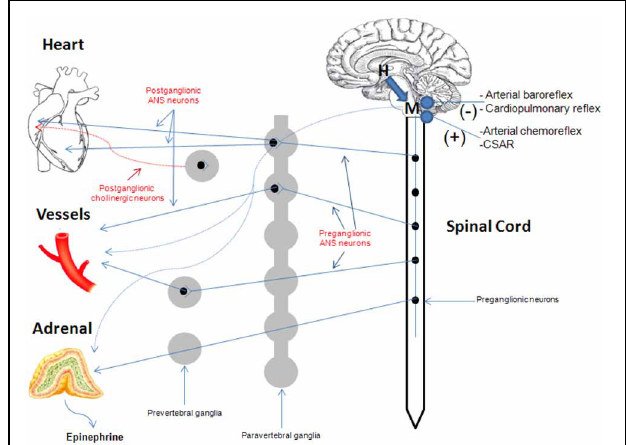
FIGURE 1 | Overview of the cardiovascular ANS. In contrast to the ANS which innervates both atria and ventricles of the heart, the cholinergic (parasympathetic) nervous system mainly innervates cardiac atria only. See text for more details. CSAR, cardiac sympathetic afferent reflex; H, hypothalamus; M, medulla oblongata.